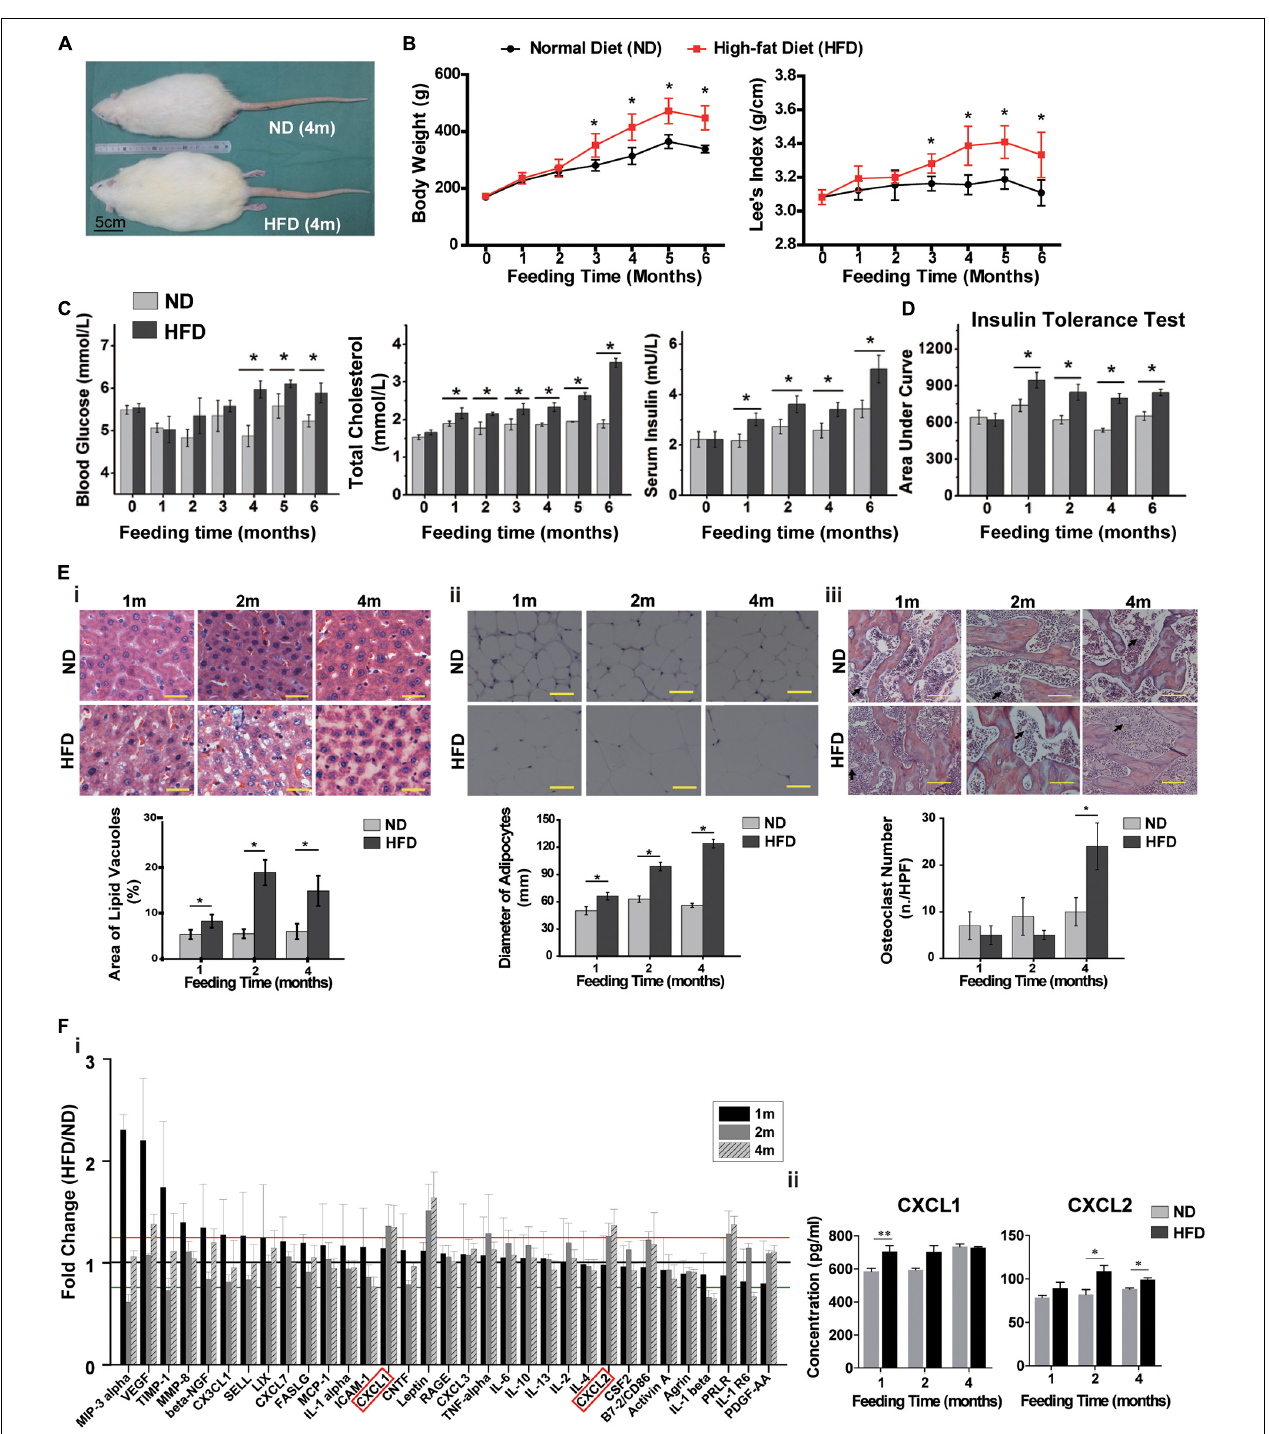
FIGURE 1 | High-fat diet alters physiological state and cytokine profiles of rats. (A) The picture of whole rat. ND, normal diet; HFD, high-fat diet, 4 m: 4 months. Scale bar, 5 cm. (B) Body weight and Lee’s index, n = 10. (C) Blood glucose, total cholesterol and serum insulin levels analysis of rats. n = 10. (D) Area under curve during insulin tolerance testing. Data represent the means ± SEM of five rats. See also Supplementary Figure 1 . (E) Representative images of H&E-stained sections and semi-quantification of liver tissues (i) , adipose tissues (ii) and bone tissues (iii) . The black arrows indicate the location of osteoclasts. Values are represented as mean ± SEM ( n = 5). Scale bars, 50 µ m. (F) Serum cytokine array analysis (i) and verification of CXCL1 and CXCL2 concentrations by ELISA (ii) . Data are presented as (mean of HFD intensity/mean of ND intensity) ± SEM ( n = 3). Black line: 1 fold, red line: 1.2 fold, green line: 0.8 fold. Two-tailed Student’s t -test were used to compare two groups of means, * p < 0.05, * p < 0.05, ** p < 0.01.